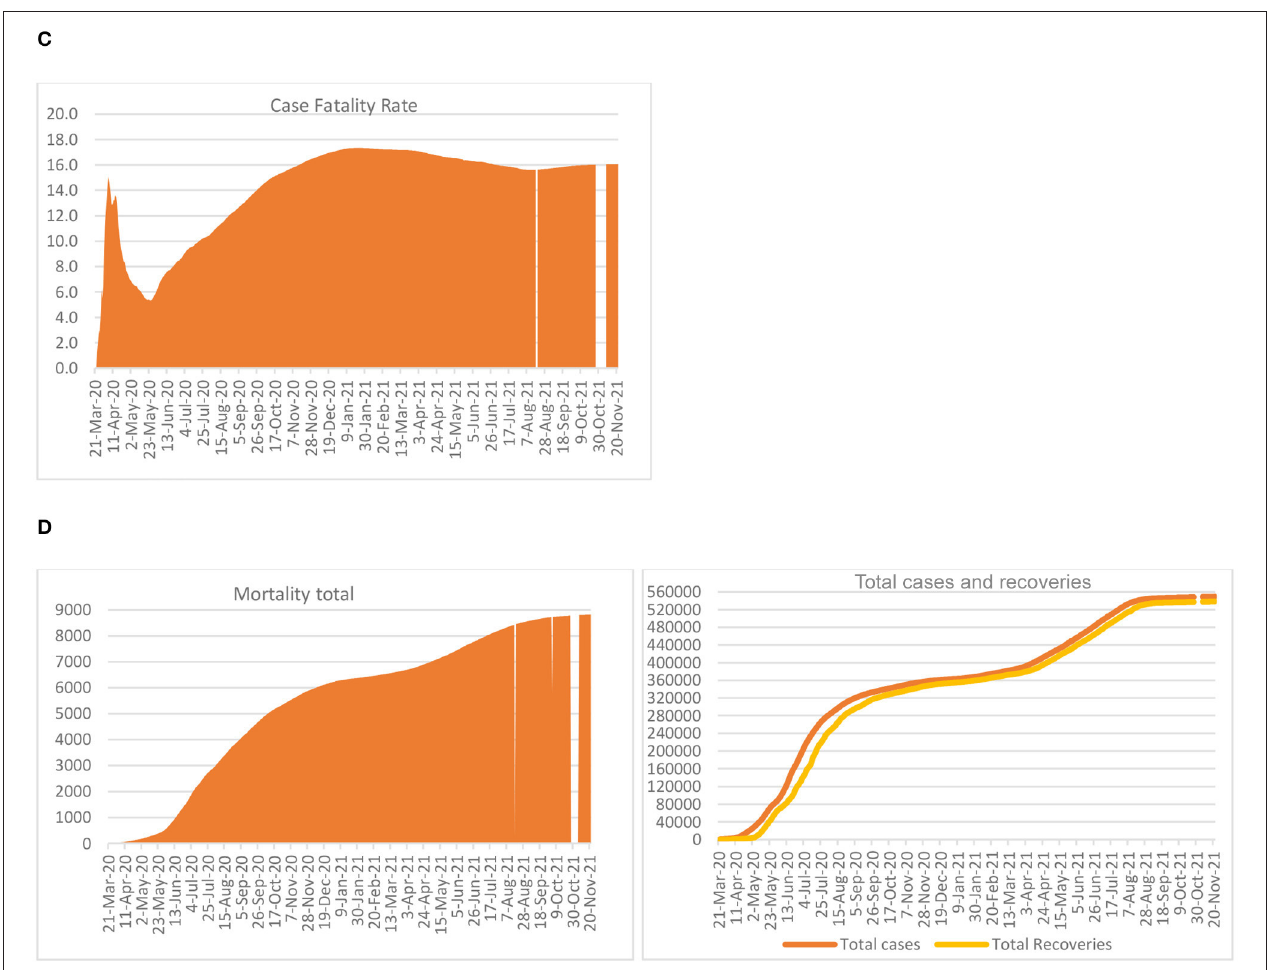
FIGURE 1 | Epidemiology of COVID-19 in Saudi Arabia. (A) Daily reports, (B) differences in daily reports, (C) case fatality, and (D) outcomes in